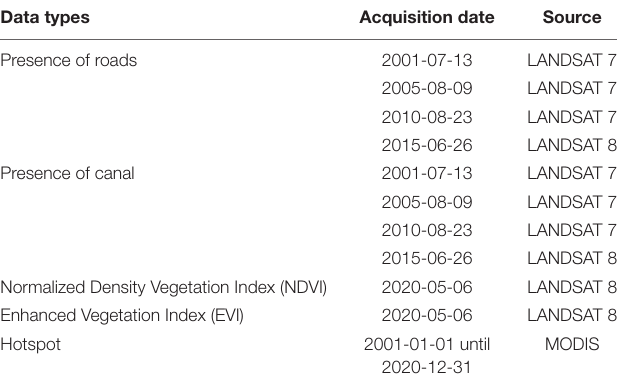
TABLE 1 | Source and acquisition date of satellite image